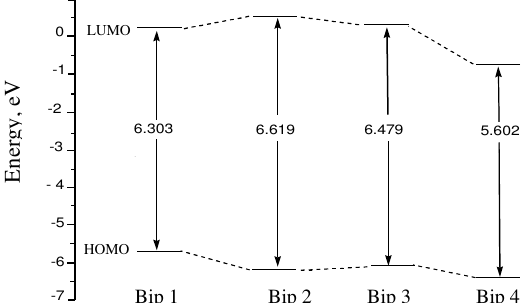
Figure 5 . Correlation diagram of frontier molecular orbitals for the investigate inhibitors and their calculated ∆ E